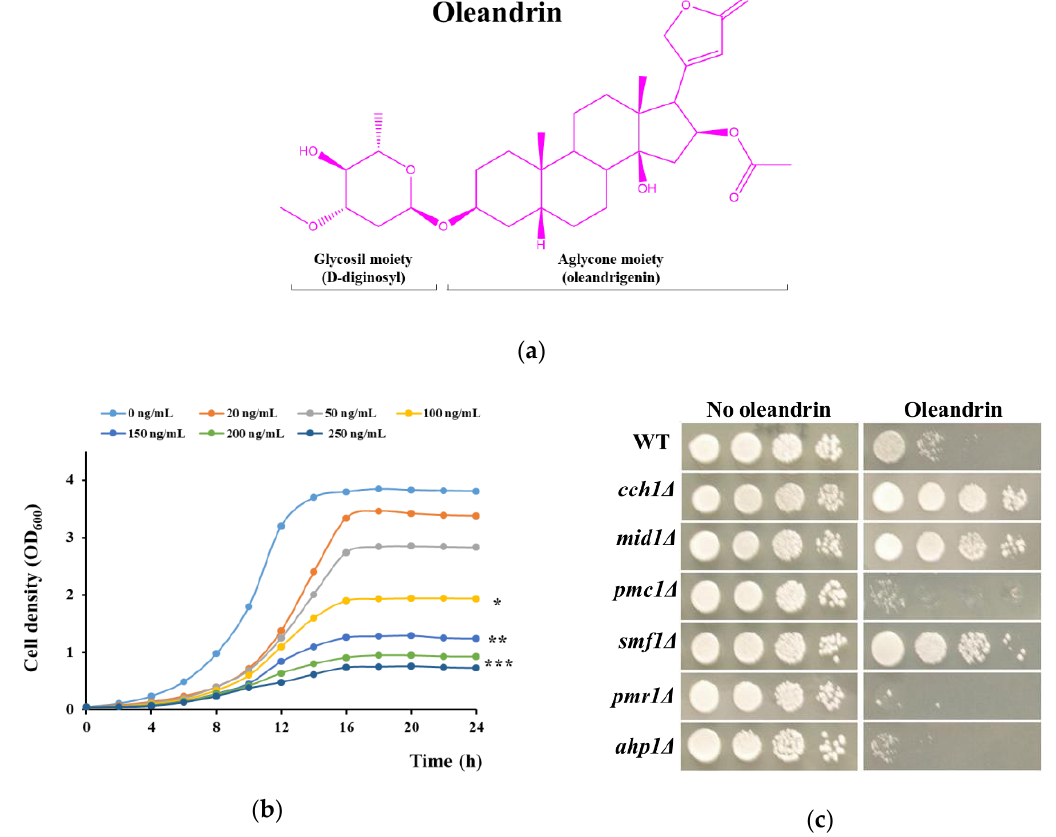
Figure 1. E ff ect of oleandrin on yeast growth. ( a ) Oleandrin structure. ( b ) E ff ect of oleandrin concentration on growth of wild type cells. BY4741 cells were inoculated (OD 600 = 0.05) and grown in SD (synthetic dextrose) liquid medium in the presence of various concentrations of oleandrin. Cell density was determined spectrophotometrically at 600 nm (OD 600 ) as described in the Materials and Methods section. One-way ANOVA, * p < 0.05; ** p < 0.01; *** p < 0.005. ( c ) Growth on oleandrin-supplemented solid medium. Wild type (WT) or knockout mutant cells cch1 ∆ , mid1 ∆ , pmc1 ∆ , smf1 ∆ , pmr1 ∆ and ahp1 ∆ with oleandrin sensitivity di ff erent from WT (see Table S1) were serially diluted and stamped on SD / agar containing or not 100 ng / mL oleandrin. Plates were photographed after 3 days’ incubation at 30 °C.